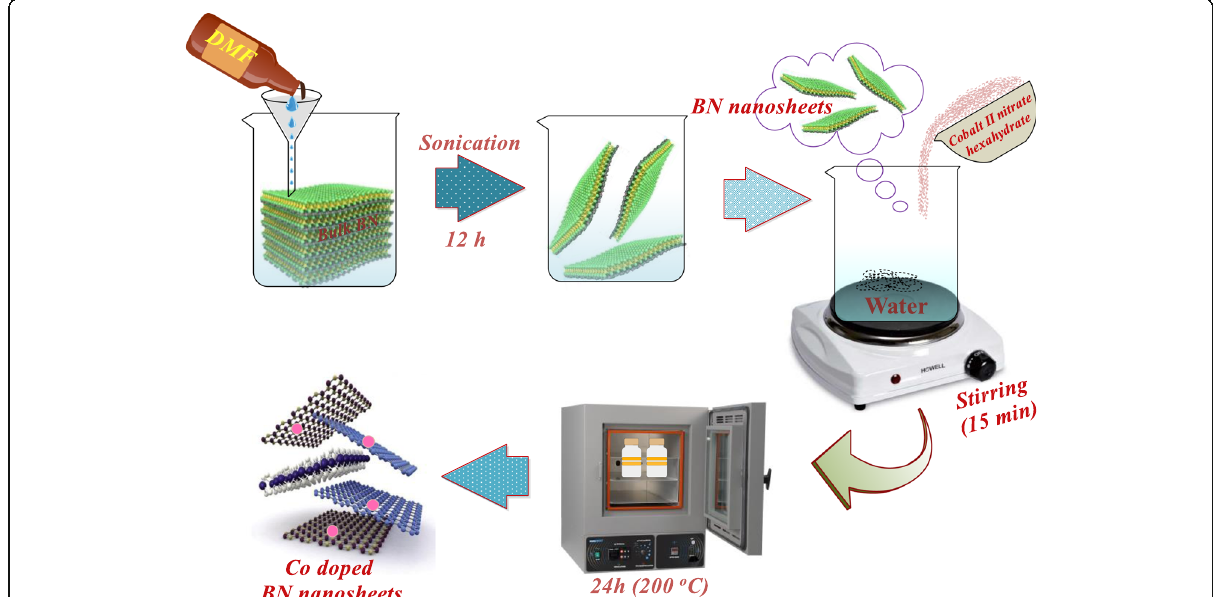
Fig. 1 Schematic illustration of exfoliation and synthesis of Co-doped